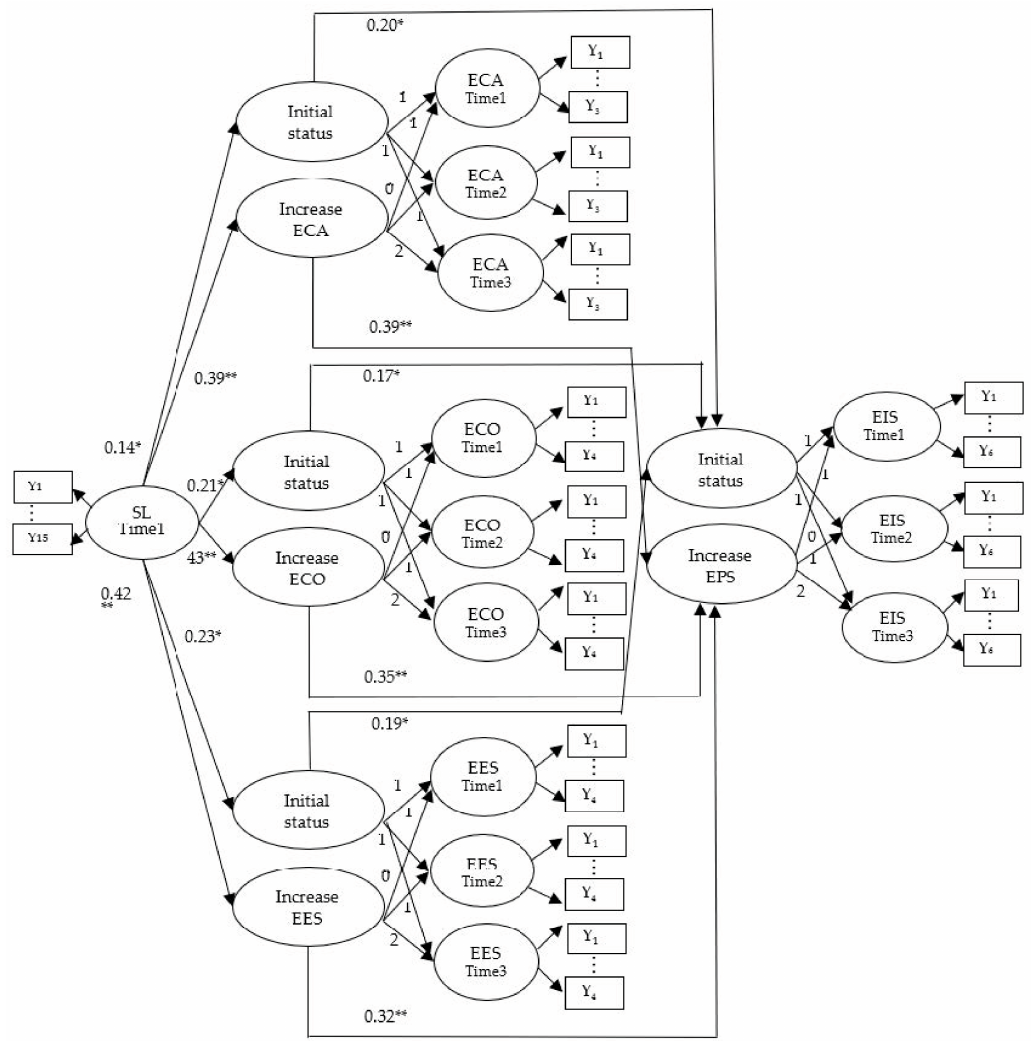
Figure 2. The latent growth curve model of this paper. Note: SL = sustainable leadership; ECA = environment categorization; ECO = environment commitment; EES = environment esteem; EIS = environmental innovation strategy. Yn = measurement items. * p < 0.05; ** p < 0.01. Time 2: three months after Time 1; Time 3: three months after Time 2.